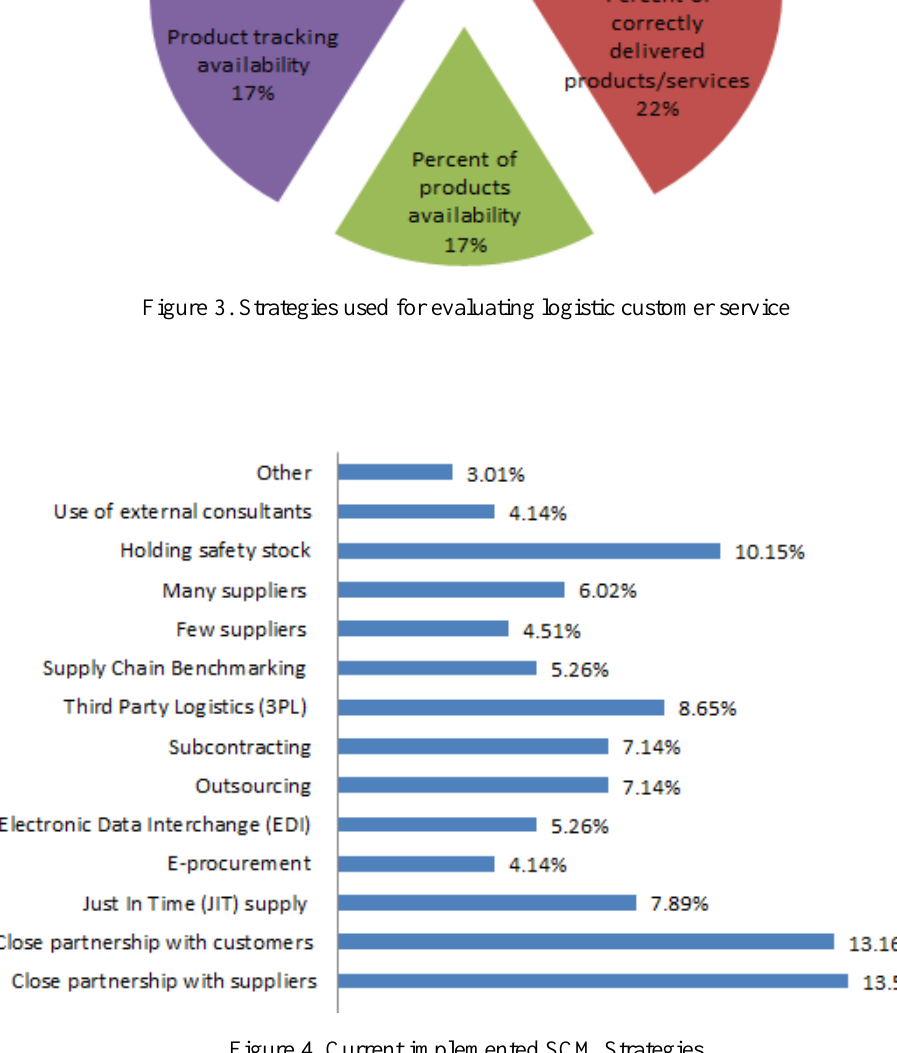
Figure 4. Current implemented SCM